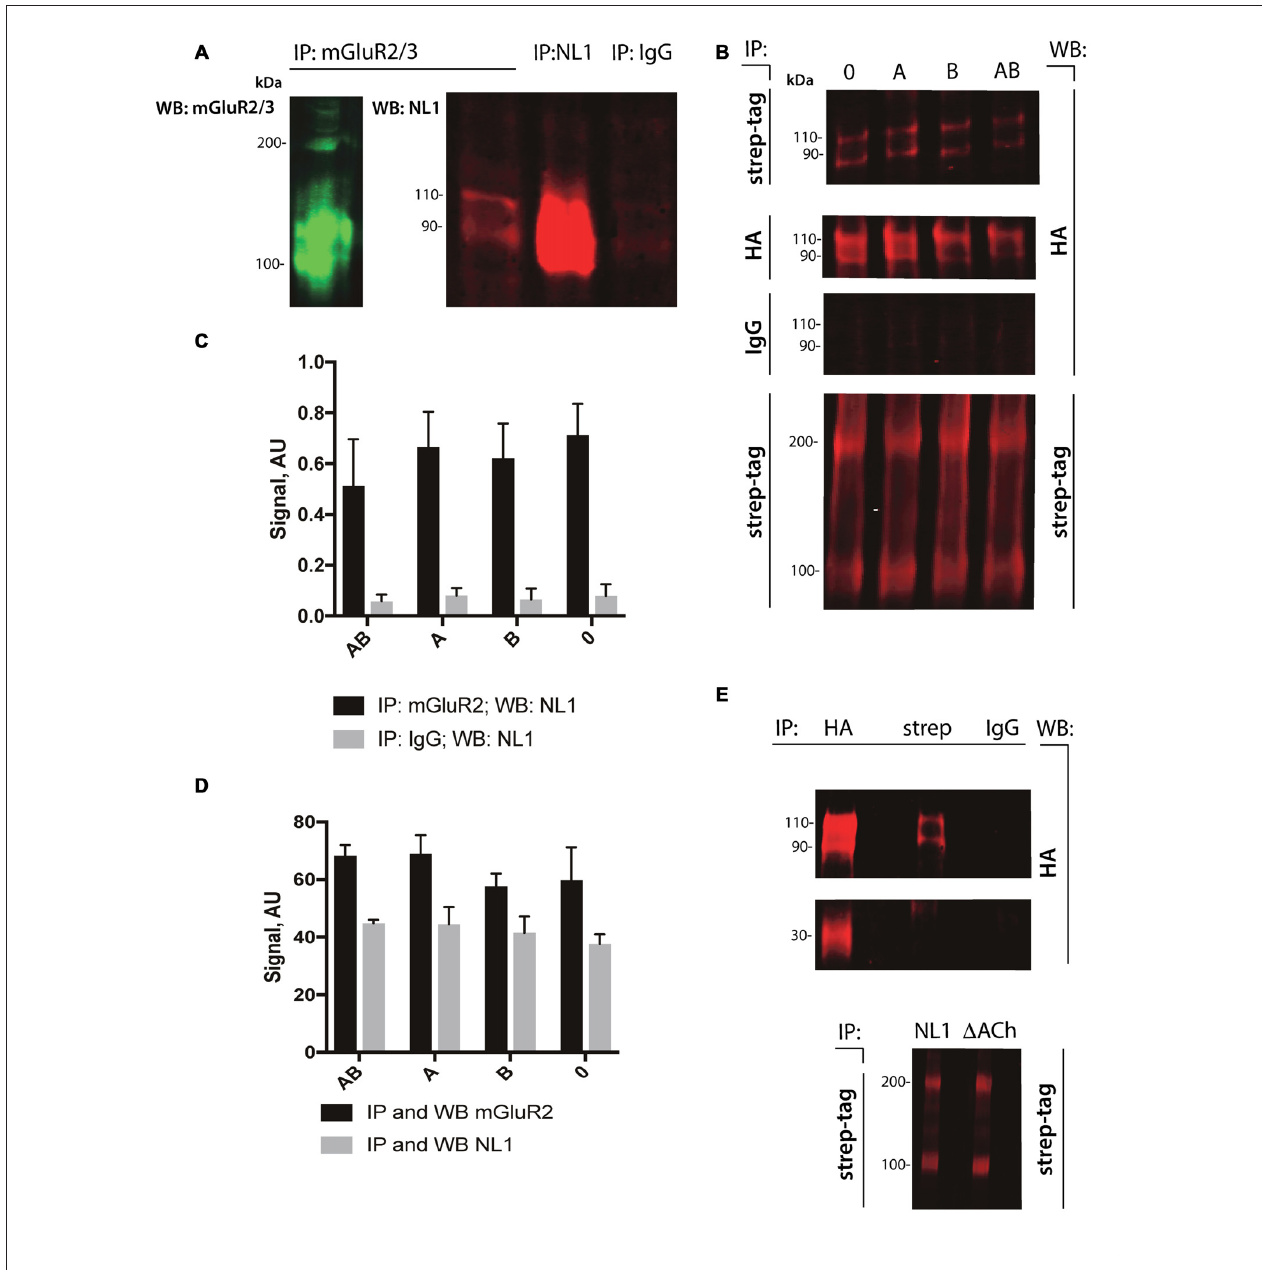
FIGURE 2 | NL1 interacts with mGluR2. (A) NL1 was immunoprecipitated from total brain lysates (P4–5) and probed (immunoblotted [WB]) with mGluR2/3 antibodies. Goat normal serum was used as a negative control (IgG). Immunoblots for mGluR2/3 yielded two bands for monomer (100 kDa) and dimer (around 200 kDa). Immunoblots for NL1 also yielded two bands for full-length protein (110 kDa) and a soluble ectodomain (around 90 kDa). (B) HEK-293 cells were transfected with HA-tagged NL1 with or without splicing sites A or B and strep-tagged mGluR2 expression vectors. Protein complexes were immunoprecipitated (IP) and probed (WB) with the indicated antibodies. Mouse IgG was used as a negative control. All HA-blots come from the same membrane. Bands at 110 and 90 kDa represent HA-NL1 full length and soluble ectodomain, respectively, and bands at 100 and 200 kDa represent mGluR2 monomer and dimer, respectively. (C,D) Quantification of immunoprecipitated NL1 from transfected HEK-293 cells. Bars represent quantified immunoblot signals ( n = 3). All HA-blots come from the same membrane. (E) HEK-293 cells were transfected with HA-tagged NL1 without splicing sites A or B or HA-tagged NL1 without AChE homology domain ( ∆ ACh) and strep-tagged mGluR2 expression vectors. (Upper panel) Protein complexes containing mGluR2 and HA-NL1 or mGluR2 and HA- ∆ ACh were immunoprecipitated (IP) with the indicated antibodies (HA, strep or IgG) and probed (WB) with anti-HA antibodies. Bands at 110 and 90 kDa represent HA-NL1 full length and soluble ectodomain, respectively, band at 30 kDa represent HA- ∆ ACh. Mouse IgG was used as a negative control. HA-blots come from the same membrane. (Lower panel) To confirm the expression of mGluR2 in HEK cells, protein complexes containing mGluR2 and HA-NL1 (NL1) or mGluR2 and HA- ∆ AChE ( ∆ ACh) were immunoprecipitated (IP) and probed (WB) with anti-streptag antibodies. Bands at 100 and 200 kDa represent mGluR2 monomer and dimer, respectively.